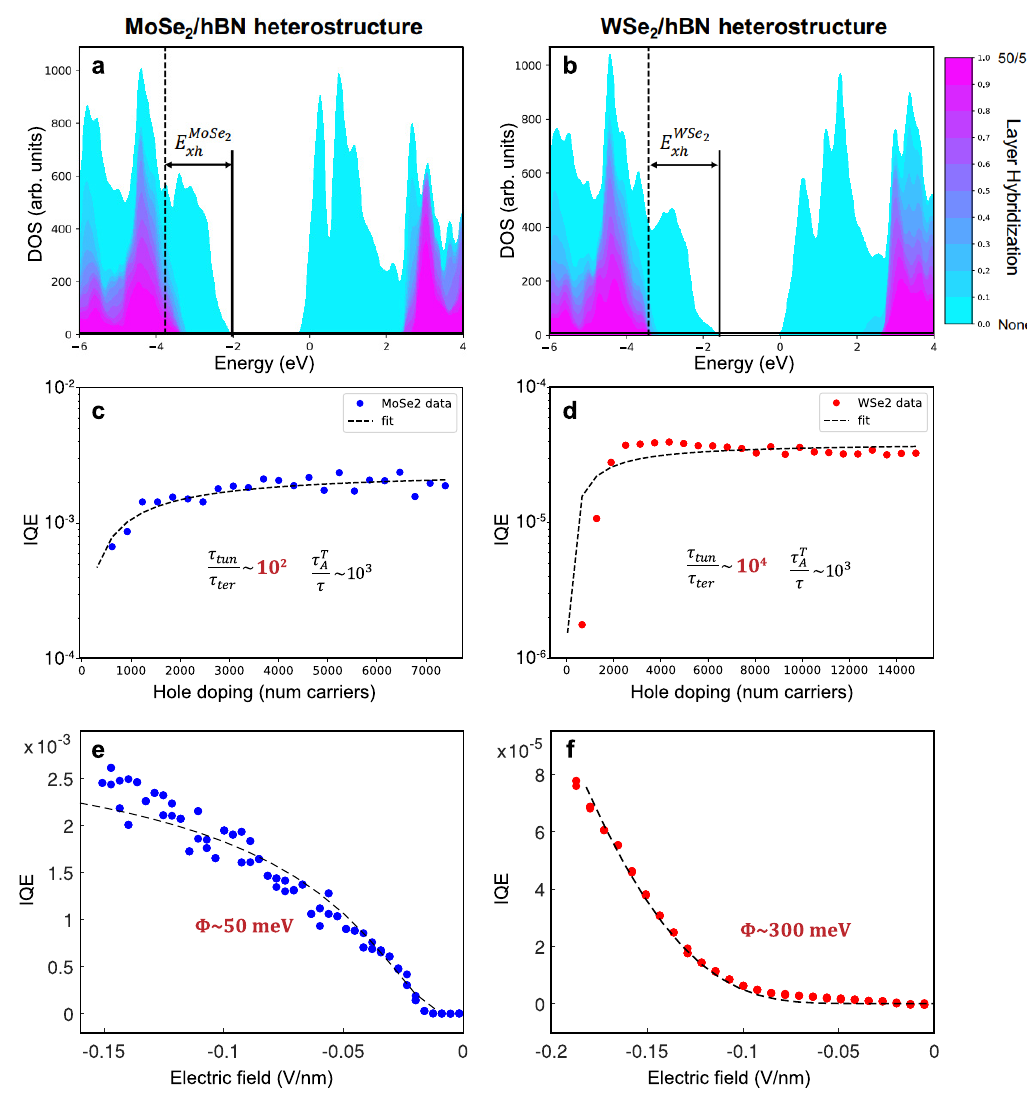
Figure 4: Band structure calculations and